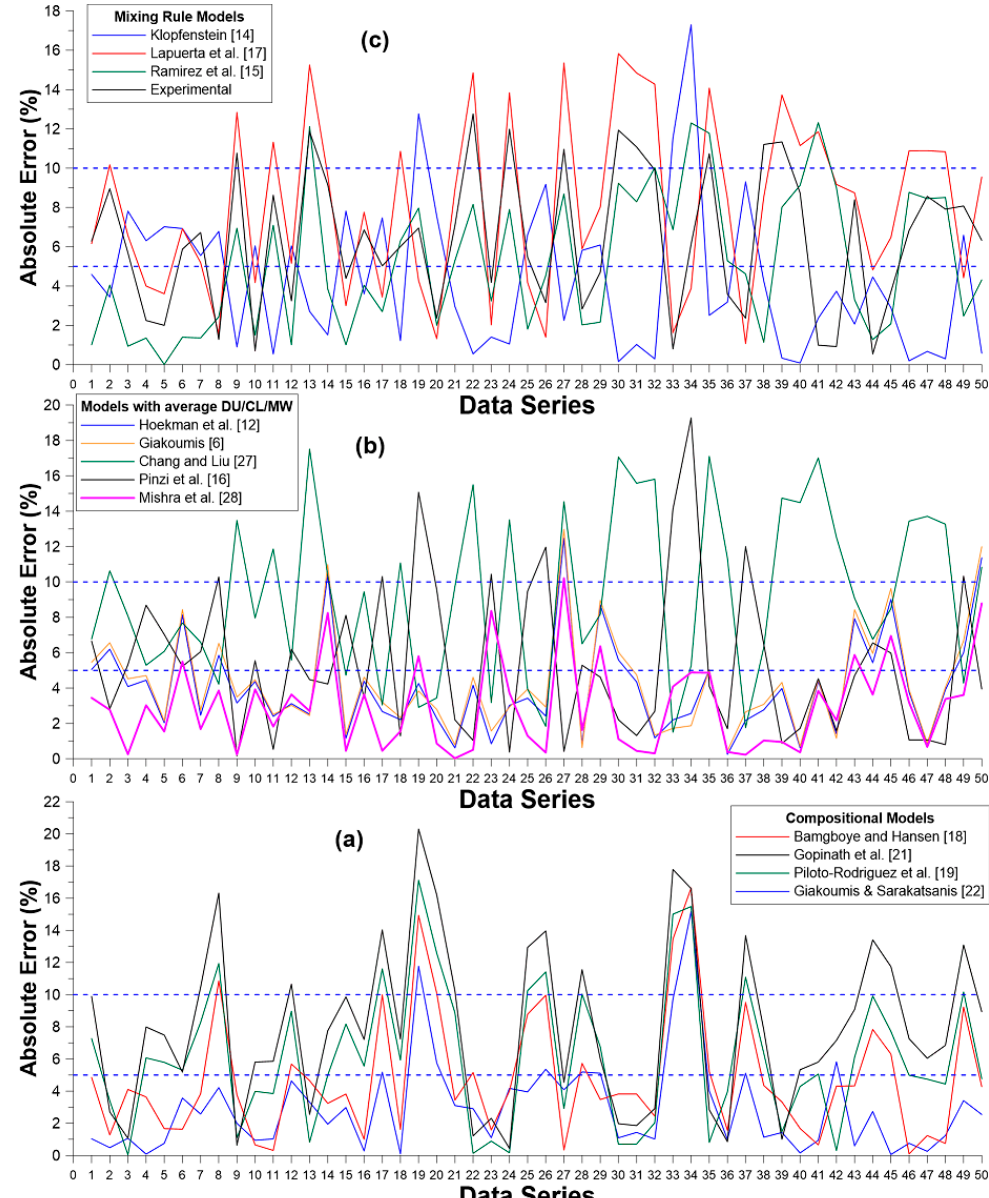
Figure 6. Absolute errors for all models (( a ): compositional; ( b ) models with average DU/CL; and ( c ) mixing rule models) and for all 50 experimental data lines.